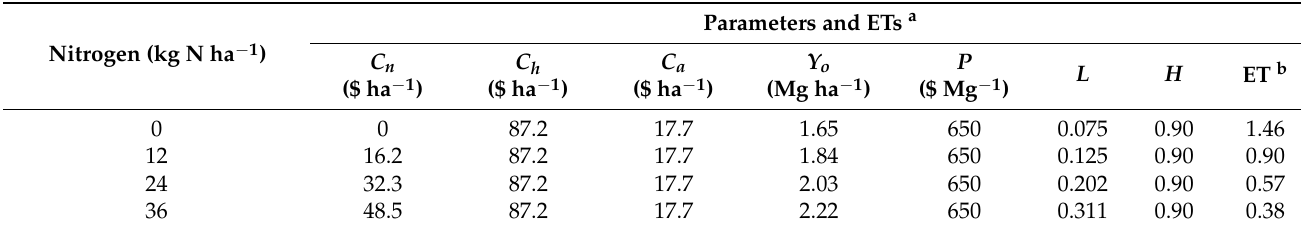
Table 5. Economic thresholds (ETs) of multiple-weed species including Ambrosia artemisiifolia , Echinochloa crus-galli , and Beckmannia syzigachne at different nitrogen levels in the pooled data.